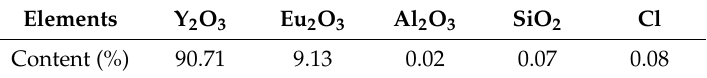
Figure 14. The XRD analysis of REOs. Table 3. Chemical composition of REOs.